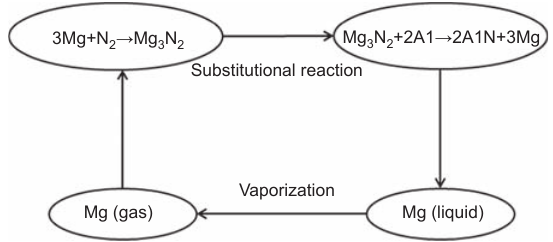
Figure 5 Mechanism of magnesium nitride formation (adapted from [22] ).